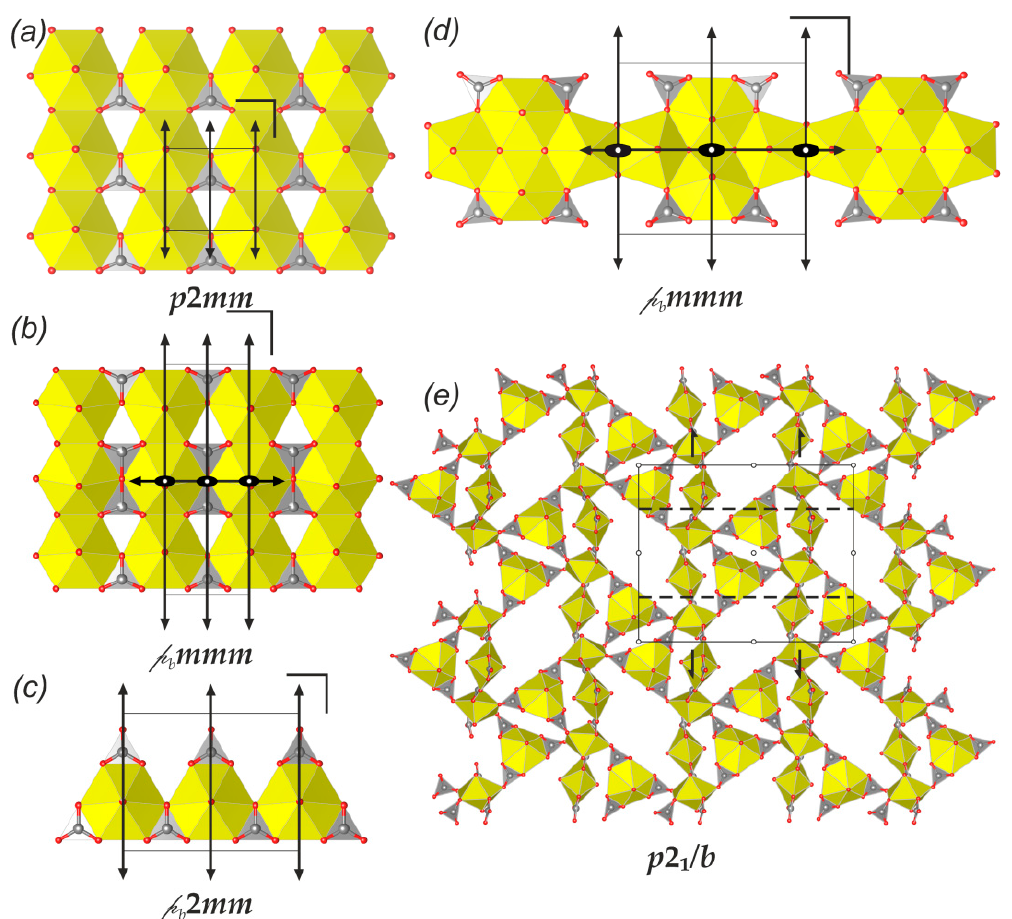
Figure 8. The crystal structures of fontanite ( a ) and marthozite ( c ), uranyl carbonate ( b ) and uranyl selenite ( d ) layers of phosphuranylite topology in their structures, and respective topological symmetry groups. Legend: see Figures 1 and 7.